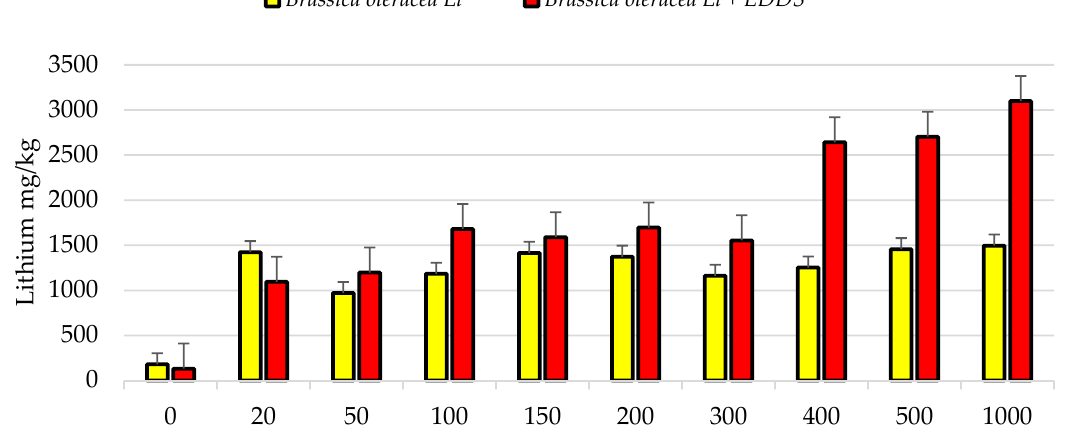
Figure 7. x ̅ Li concentration in leaves of Brassica oleracea from trial 1 (No chelator) and Brassica oleracea from trial 3 (EDDS treatments at 0.05M) X-axis, concentration of Li amended to the soil. (Units in mg/kg).